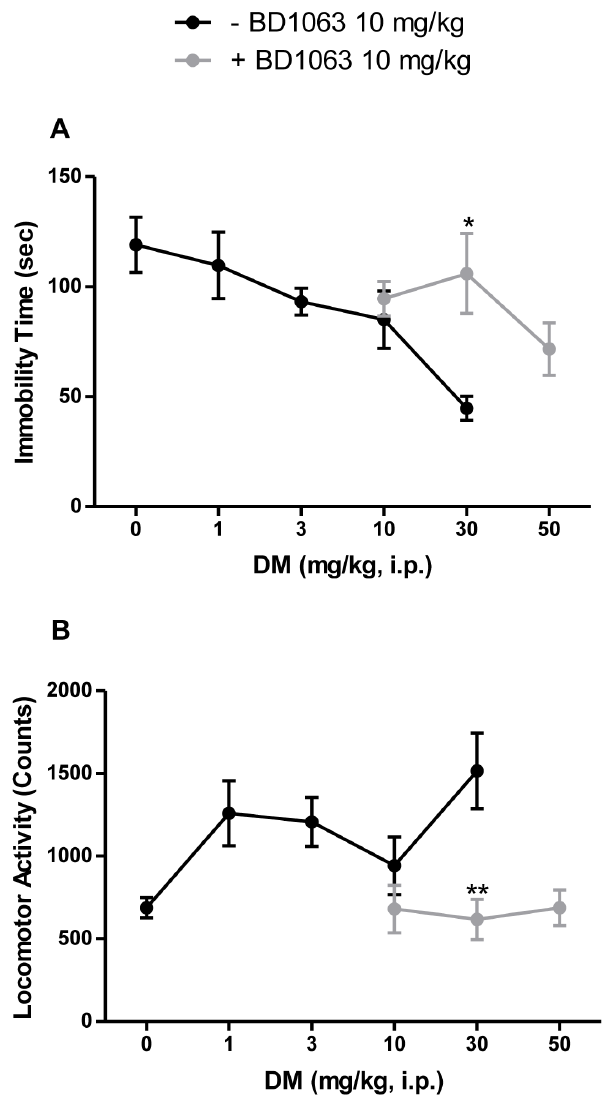
Figure 3. Competitive antagonism of the behavioral effects of dextromethorphan by BD1063. A single dose of BD1063 (10 mg/ kg, i.p.) pretreatment shifted the dextromethorphan (0–50 mg/kg, i.p.) dose response curve to the right in the forced swim test (A), and blocked the dextromethorphan-induced stimulatory effect in the locomotor study (B). Data shown are expressed as mean 6 S.E.M. * P , 0.05, ** P , 0.01 compared with the dextromethorphan (30 mg/kg, i.p.)-treated group; one-way ANOVA followed by post-hoc Tukey’s tests. DM, dextromethorphan.